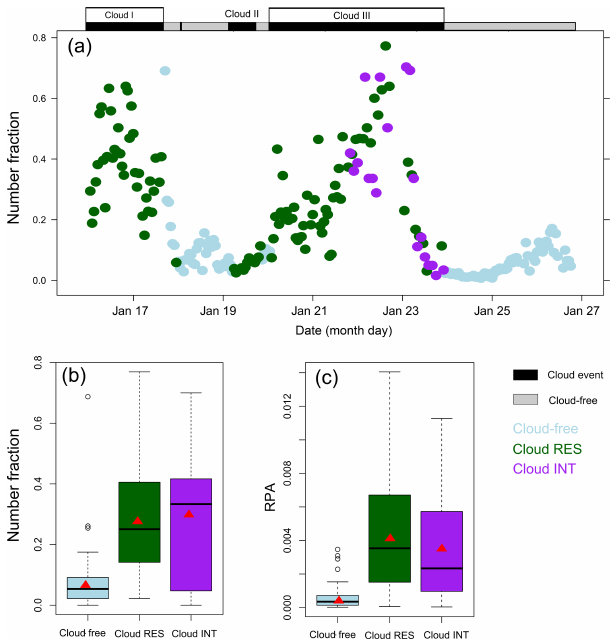
Figure 1. (a) Temporal variation (in 1-hour resolution) of num- ber fractions (Nfs) of the oxalate-containing particles, box-and- whisker plots of (b) the Nfs of oxalate-containing particles as shown in (a) , and (c) the relative peak area (RPA) of oxalate, separated for the cloud-free, cloud RES, and cloud INT particles. In a box-and- whisker plot, the lower, median, and upper line of the box denote the 25, 50, and 75 percentiles, respectively; the lower and upper edges of the whisker denote the 10 and 90 percentiles, respectively. Red triangles refer to the arithmetical mean values of the Nfs and RPAs shown in panels (b) and (c)